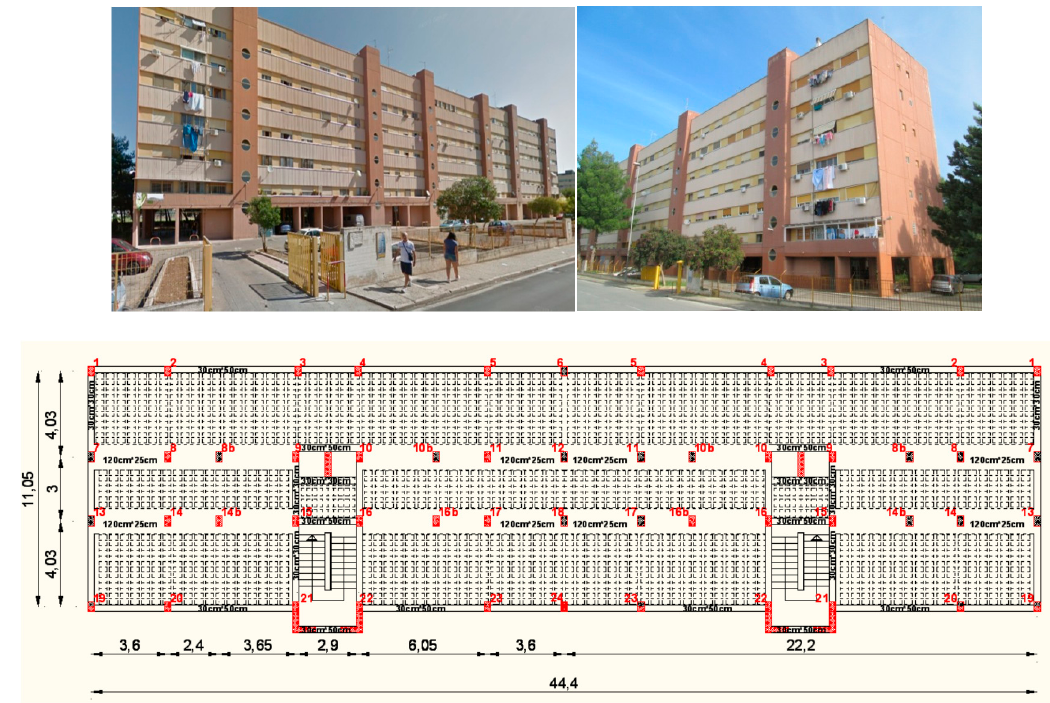
Figure 8. Building to retrofit with external steel frames (Santa Rita district, Bari, Italy).